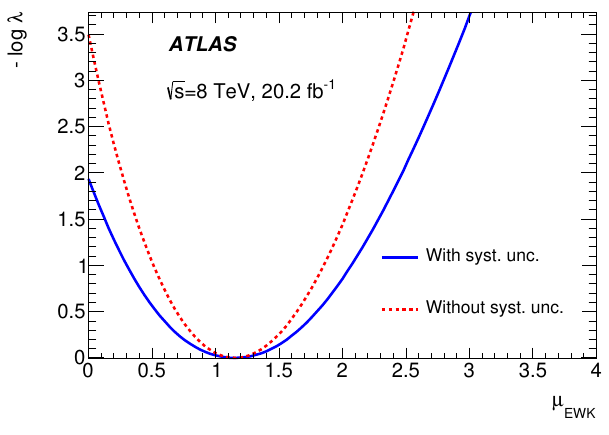
Figure 7 . The pro(cid:12)le of the negative log-likelihood ratio (cid:21) ( (cid:22) EWK ) of the signal strength (cid:22) EWK of the (cid:16) Z(cid:13) template. The observed result is shown by the solid curve, while the dashed curve shows the results with only the statistical uncertainty included. The observed signi(cid:12)cance of the measurement p is given by (cid:0) 2 log (cid:21) (0) and equals 2.0 (cid:27) in this